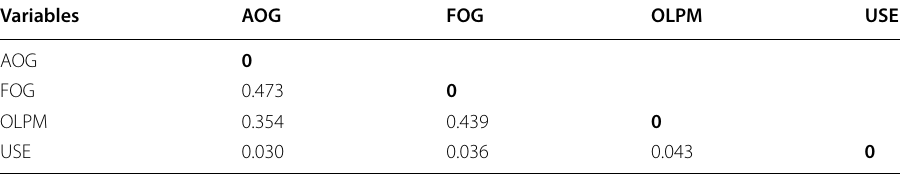
The bolded zero (0) values mean that there is no discrimination of the same variable on itself